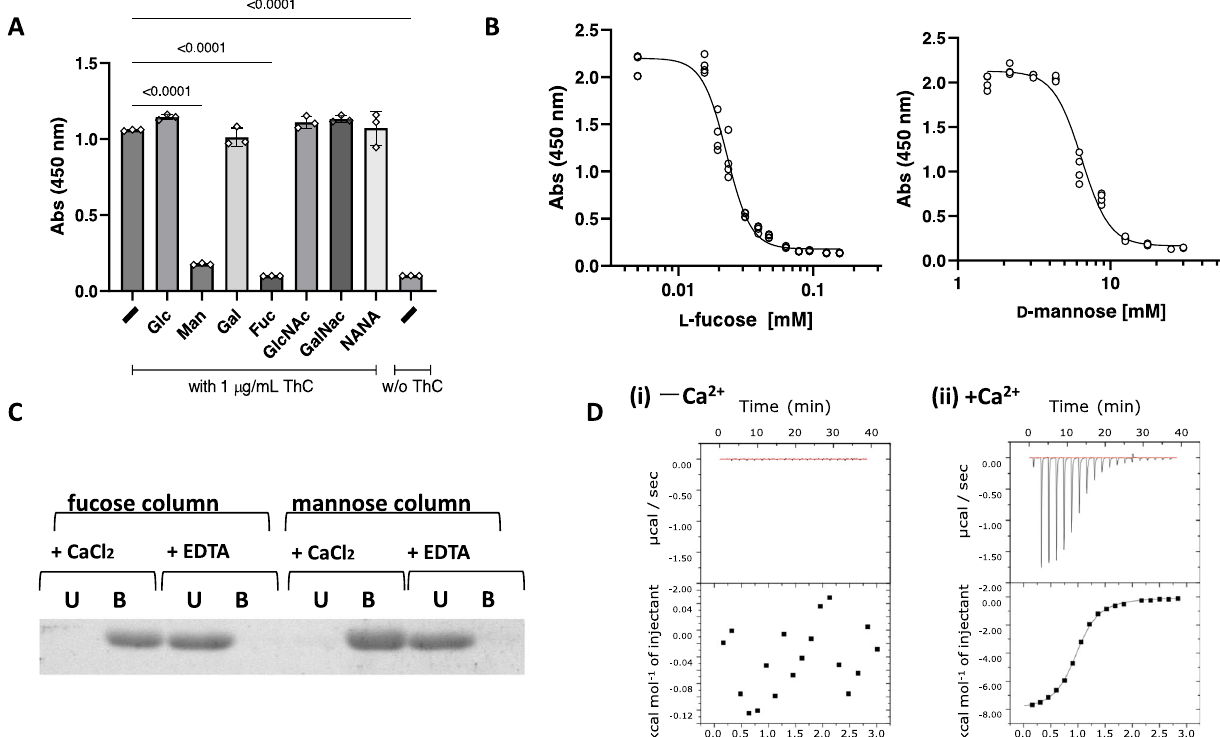
Fig. 2 | Critical role of sugar-binding capacity in ThC-dependent MPL activa- tion. A Relative cell proliferation in the presence of various sugars (10mM) in Ba/ F3-HuMpl cells with rThC (1 μ g/mL). n =3 per data point, bars±SD. One-way ANOVA followed by a Dunnett ’ s test for multiple group comparison. B Concentration-dependent inhibition of fucose or mannose on cell proliferation by rThC treatment (1 μ g/mL). IC 50 for fucose and mannose were 22.8 (95% CI of